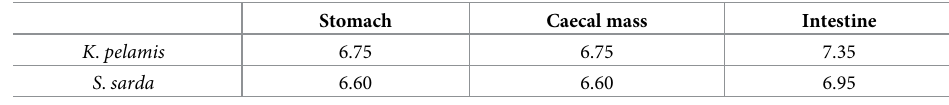
pH values of buffers used for the measurement of enzymatic activity for each species and digestive